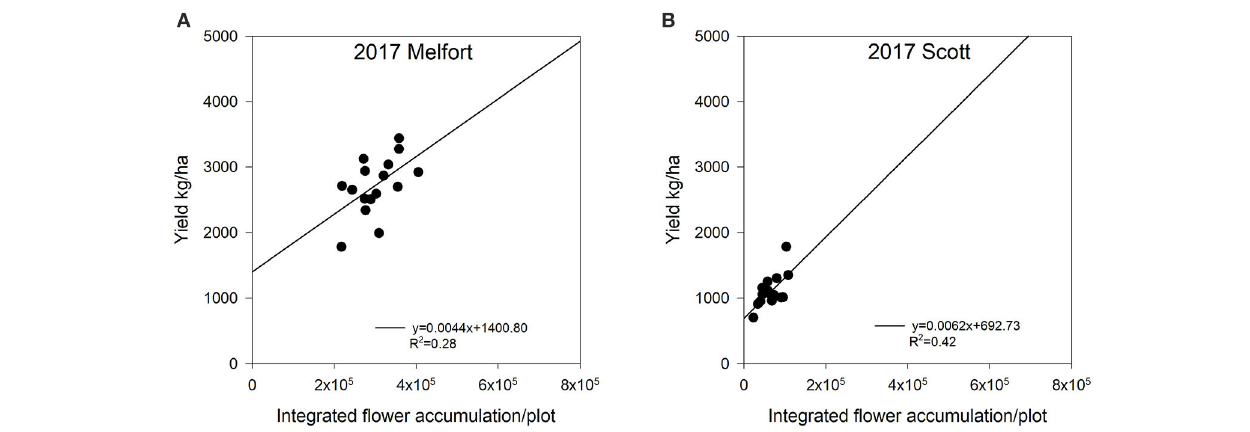
FIGURE 9 | The relationship between seed yield and integrated flower accumulation at Melfort and Scott, SK, Canada in 2017. The integrated flower accumulation was calculated using the area under the flowering progress curve function. (A) Regression for the Melfort location in 2017: y = 0.0044x + 1400.80, R 2 = 0.28. (B) Regression for the Scott location in 2017: y = 0.0062x + 692.73, R 2 =